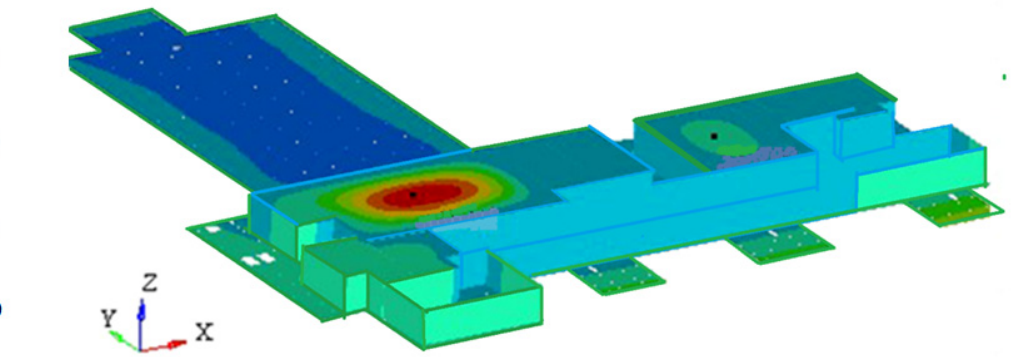
Figure 15. Distribution of the vertical displacements around points 1 and 2.